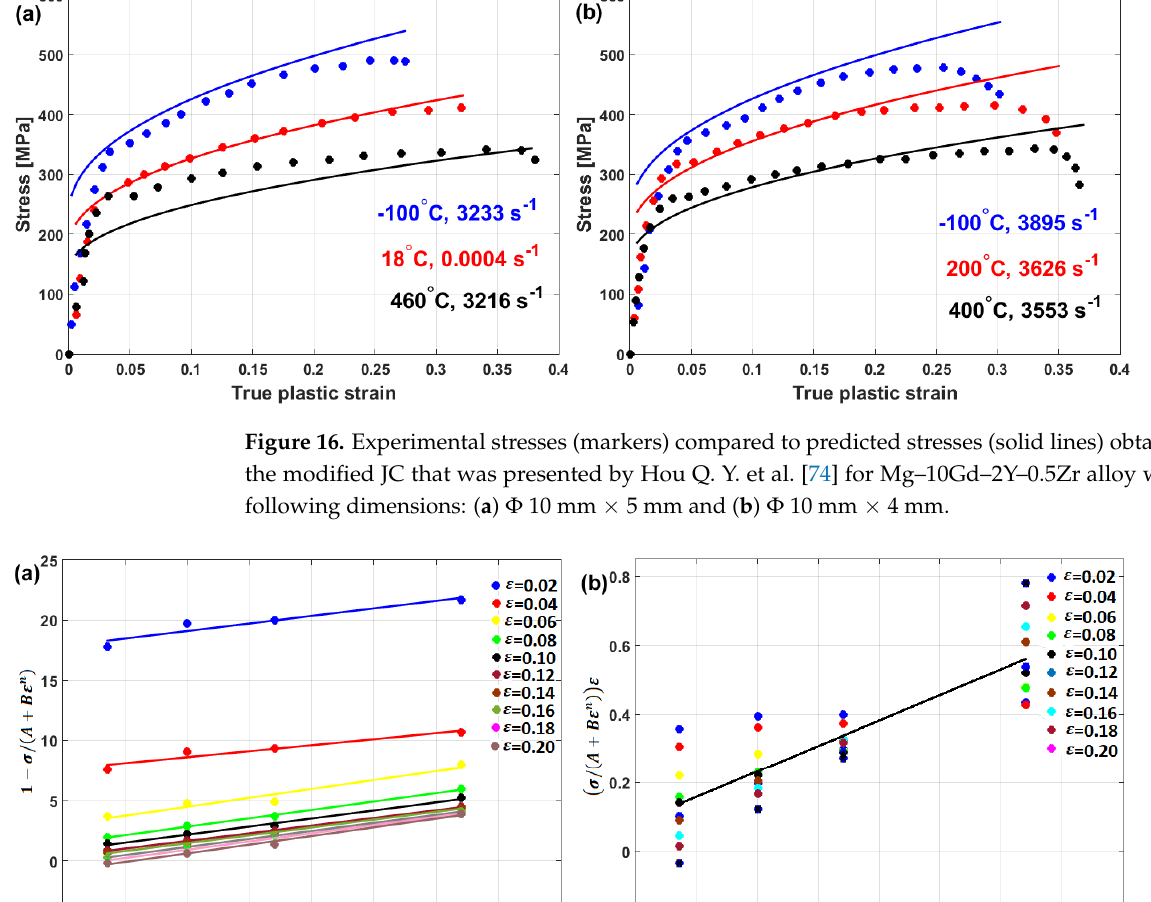
14 of 54 Figure 15. Experimental stresses (markers) compared to predicted stresses (solid lines) obtained by the modified JC model that was presented by Lin et al. [73] for typical high-strength alloy steel at ( a ) 1123 K and ( b ) 1323 K. 3.2.6. Hou Q. Y. JC-Based Modification Hou Q. Y. et al. [74] modified the softening term in the original JC model, considering that the tested temperature might be higher or lower than the reference temperature. The modified JC model that was presented by Hou Q. Y. et al. [74] can be expressed as 𝜎 = (𝐴 + 𝐵𝜀 𝑛 )(1 + 𝐶 ln 𝜀 ∙∗ ) (1 − 𝜆 𝑒 𝑇/𝑇 𝑚 − 𝑒 𝑇 𝑟 /𝑇 𝑚 𝑒 − 𝑒 𝑇 𝑟 /𝑇 𝑚 ) (20) where constants 𝐴, 𝐵, 𝑛, and 𝐶 are determined as was explained for the original JC model (see Section 3.1). At different strain rate values, after performing some rearrangements, Equation (20) can be written as 1 −